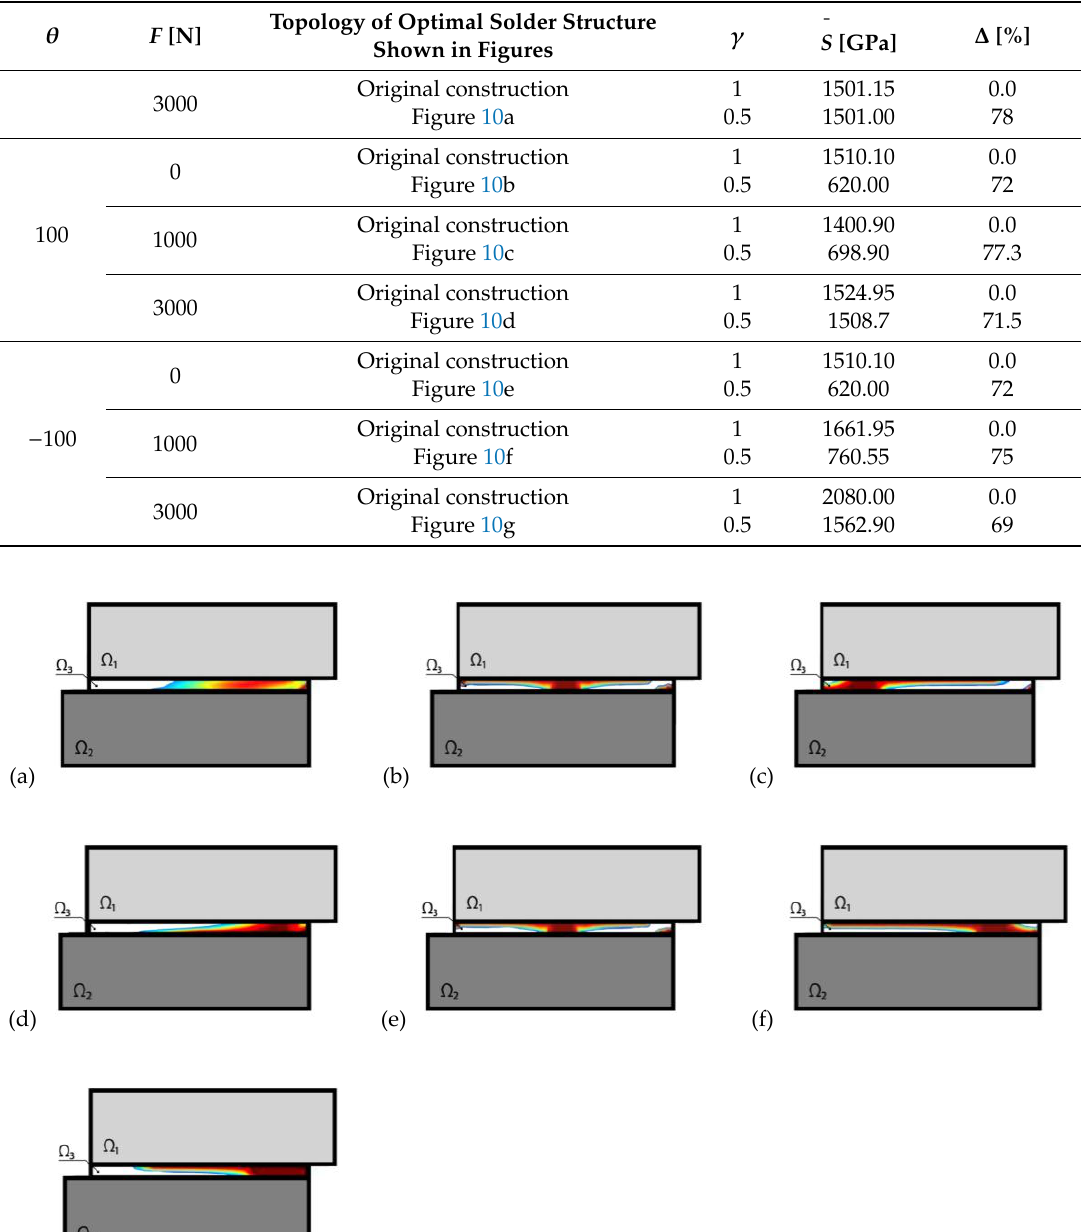
Table 4. Comparing results of the topological optimization under thermal and mechanical loads with the original construction.